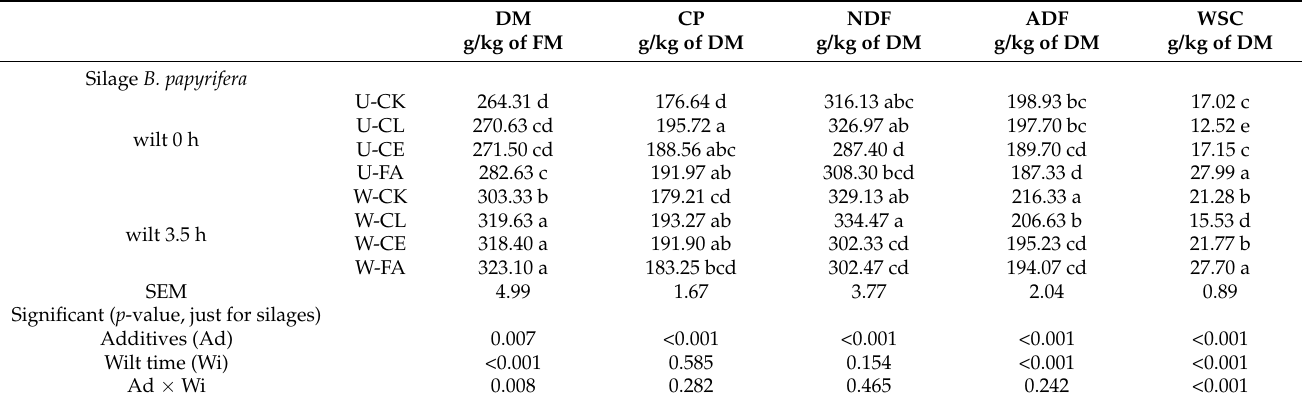
Table 2. The chemical positions of B. papyrifera silage with additives.